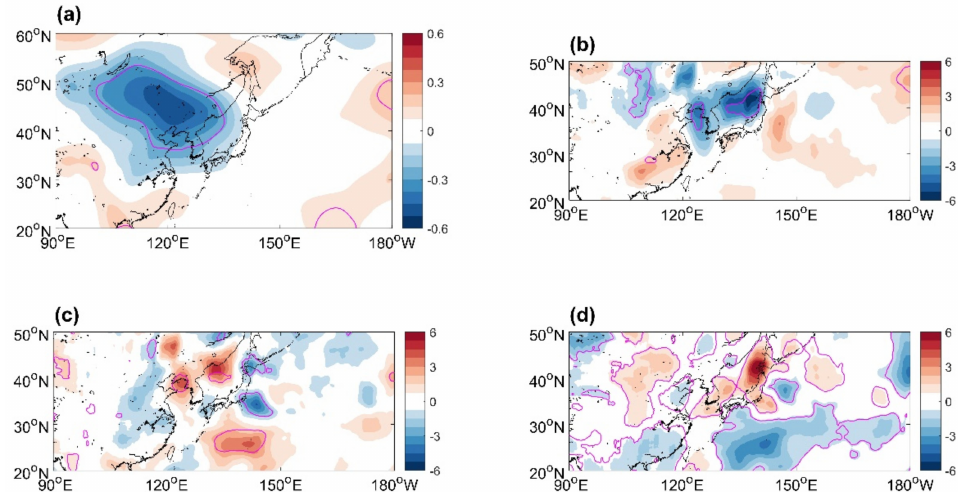
Figure 10. The estimated responses of ( a ) local air-temperature change (shading, unit: 10 − 6 Ks − 1 ), ( b ) horizontal heat transport (shading, unit: 10 − 6 Ks − 1 ), ( c ) vertical heat transport (shading, unit: 10 − 6 Ks − 1 ), and ( d ) diabatic heating (shading, unit: 10 − 6 Ks − 1 ) at the 850-hPa level in DJF onto the KEI 2 months earlier. The data have been smoothed using a 10 ◦ × 10 ◦ spatial average for cleaner visibility. Stippling indicates the 90% confidence